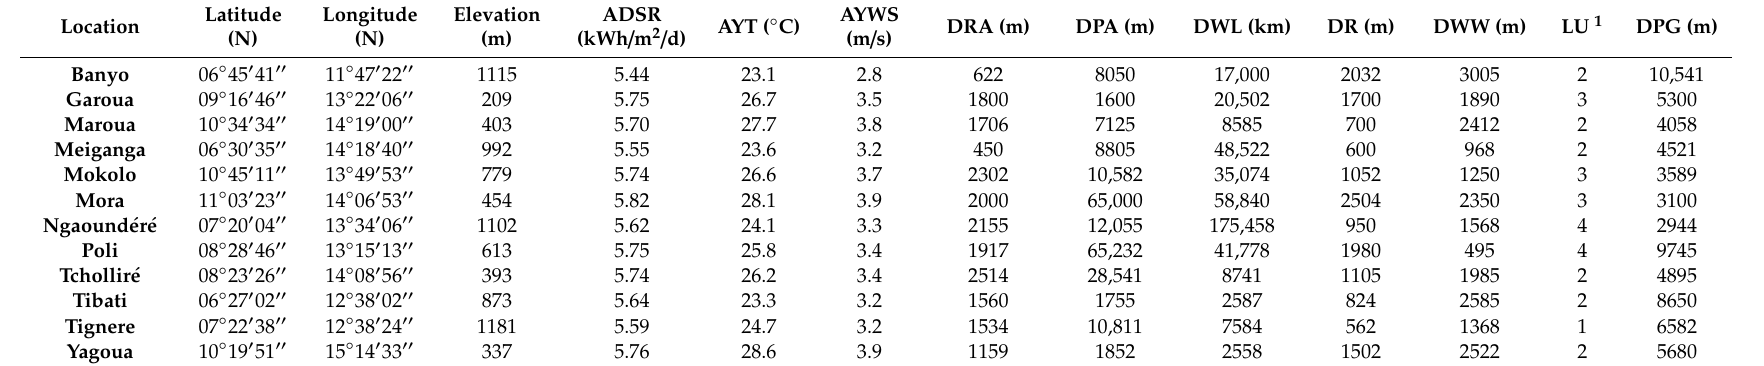
Table 2. Alternative sites ‘coordinates and their respective